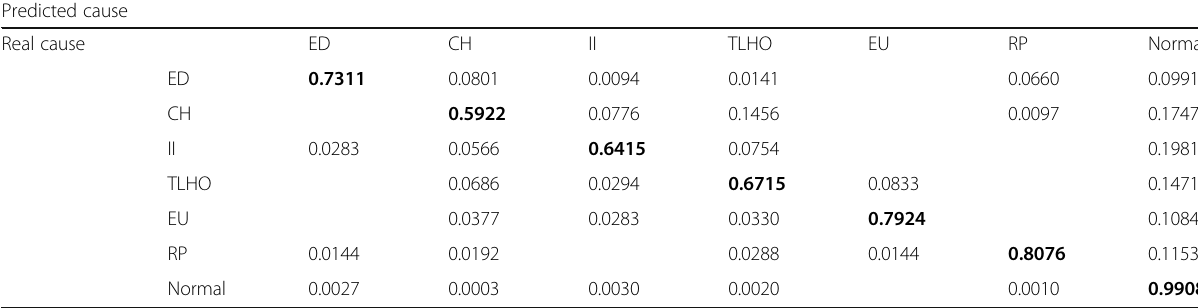
Table 7 Normalized confusion matrix of GA-AdaBoostRBFSVM method with optimal parameter values Predicted cause